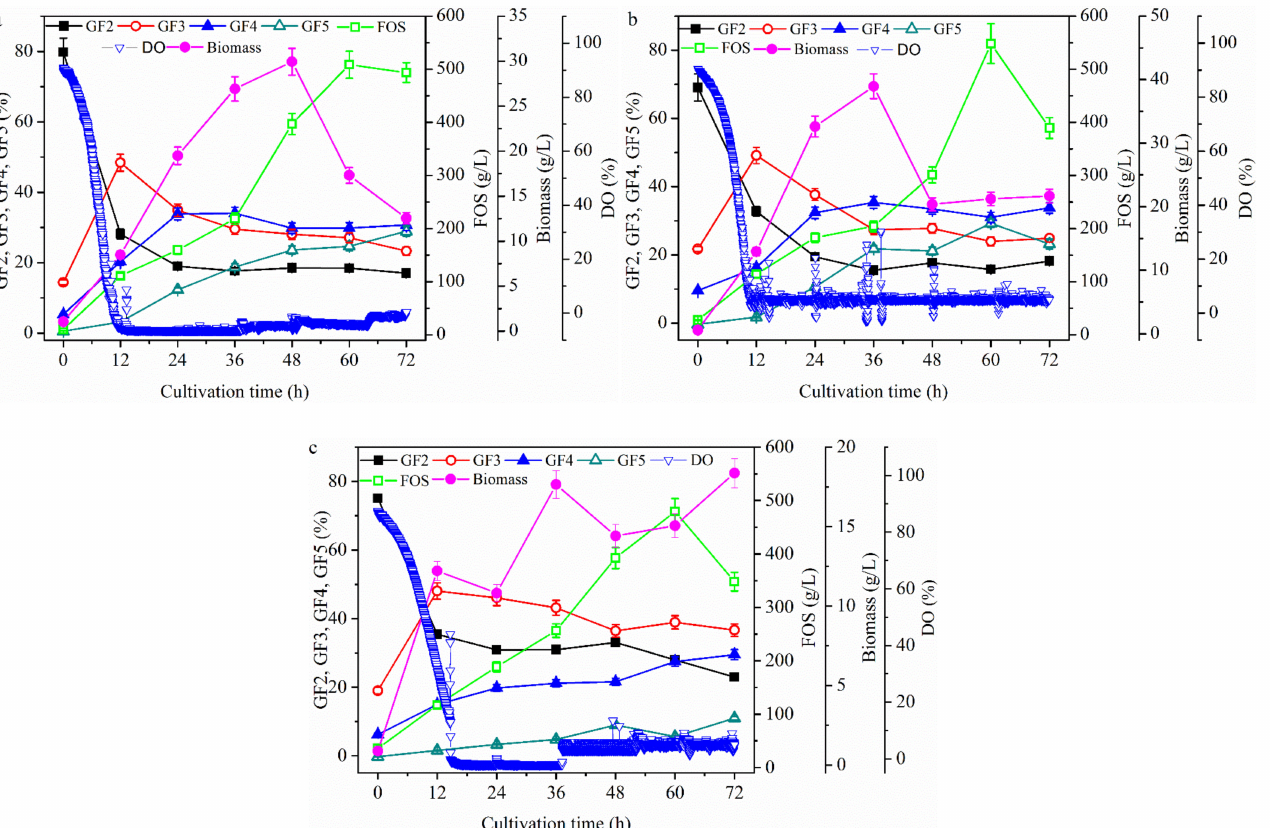
Figure 6. FOS production in a repeated-batch culture with 500 mL broth discharged each time. Repeated -batch cultivations at 25 ◦ C and pH 5.5 were conducted at 600 rpm and 1.8 L/min ( a ), 5% dissolved oxygen (DO) that was cascaded to stirring speed through proportion integral differential (PID) control ( b ), and 600 rpm and 0 L/min after culturing under 600 rpm and 1.8 L/min for 12 h ( c ). For 5% DO control, the DO was allowed to automatically drop to 5% and then controlled constantly by manually adjusting the partial pressure of the bioreactor and automatically adjusting the stirring speed using the PID controller. Data are given as the mean ± SD, n =